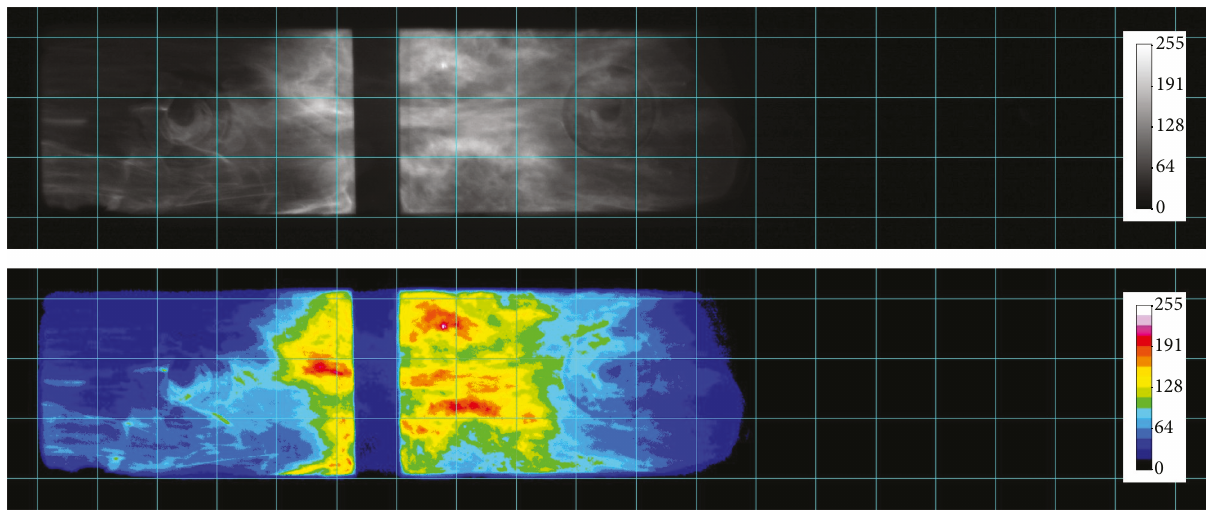
Figure 10: Grayscale-to-color processing of images taken using a high-speed camera ( BR = 31 13